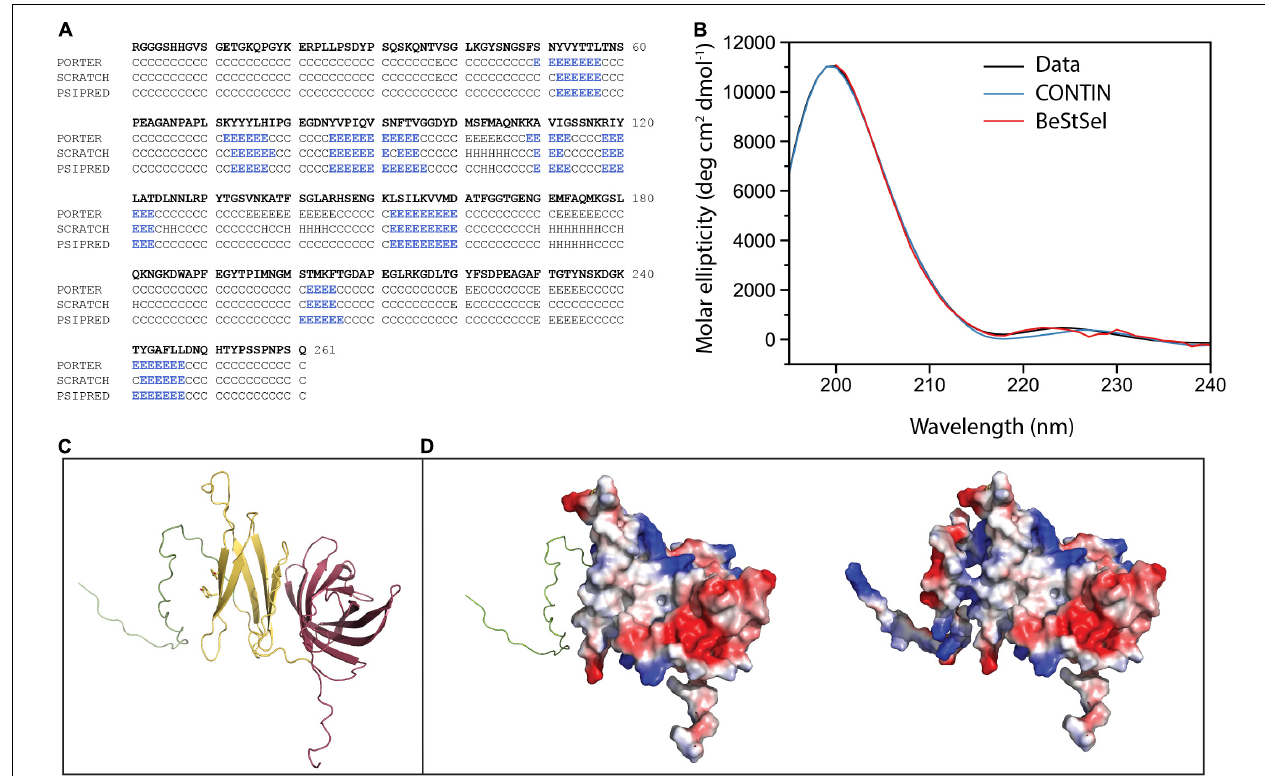
FIGURE 2 | NilC secondary structure and structural models. (A) Secondary structure prediction for NilC 22 − 282 was performed using Porter, Scratch, and Psipred algorithms (E β -strand, H α -helix, C random coil) with blue highlighting indicating the β -strand elements predicted by each. (B) A NilC 22 − 282 CD spectrum was collected at 25 ◦ C in an AVIV model 420 CD spectrometer. Deconvolution of the spectra using two algorithms leads to excellent agreement with experimental measurement. (C) The NilC structural model showing disordered N-term (green), a relatively flexible N-terminal effector domain (yellow), and an 8-stranded barrel TXISS-targeting domain (purple). The two tyrosines conserved among Xenorhabdus NilC homologs are shown. (D) On the left, the electrostatic surface of effector and barrel domains (red, negative; blue, positive; and white, neutral charge densities) is shown, and, on the right, the electrostatic surface of entire protein, suggesting the charged N-terminal extension may help solubilize the protein despite the hydrophobic